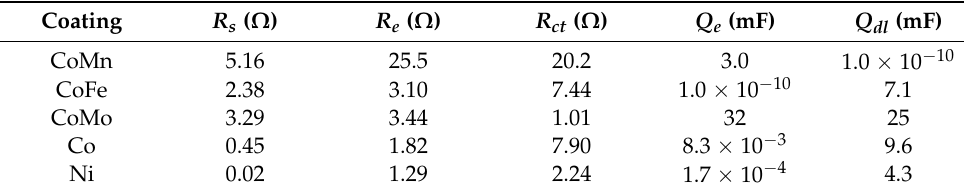
Table 6. EIS parameters of OER at the studied coatings in 1 M KOH at 1.67 V (amplitude of 5 mV in the 100 kHz–0.1 Hz range).